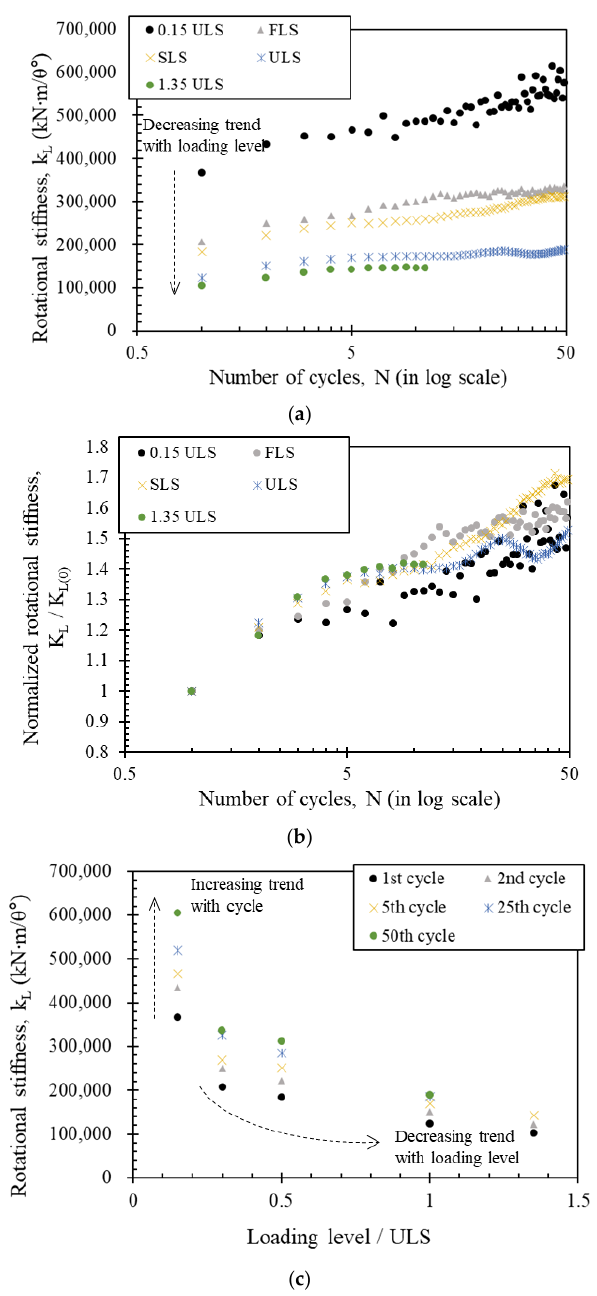
Figure 10. Loading stiffness responses with loading amplitudes: ( a ) ground stiffness – number of cycles curve; ( b ) normalized stiffness with respect to first cycle stiffness; ( c ) ground stiffness – normalized loading level curve.